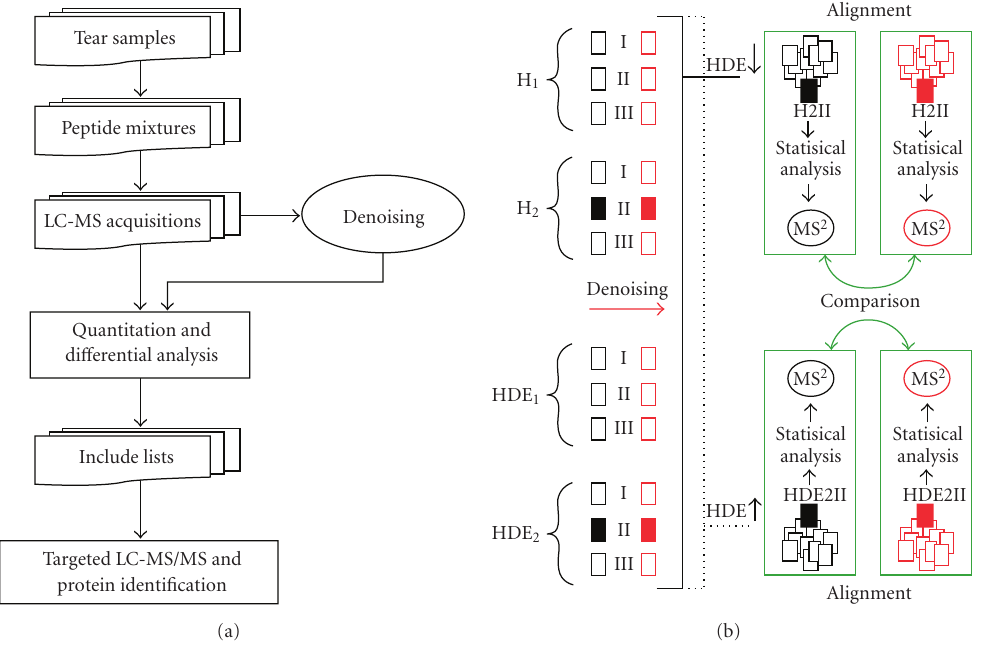
Figure 1: Typical pipeline for comparative LC-MS analysis. (a) The preprocessing step of noise rejection is shown as optional to the common workflow. (b) Details of the bioinformatic steps: in black the standard workflow, in red the alternative workflow subsequent to noise rejection, and in green the comparison of the results obtained by the two